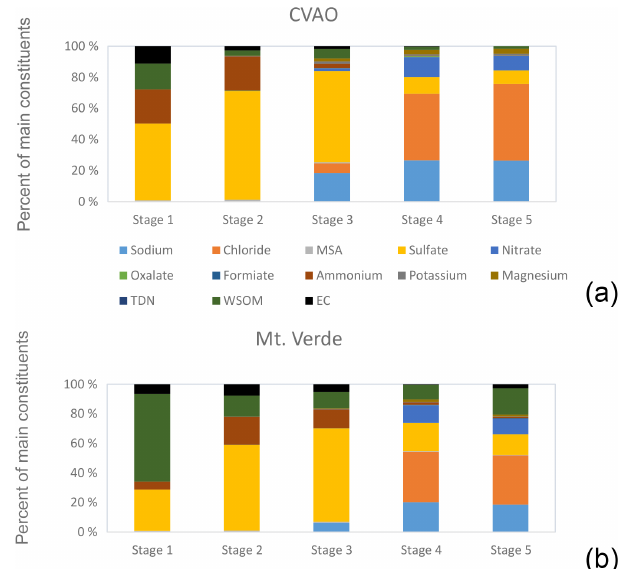
Figure 11. (a) Percentage aerosol composition at the CVAO (mean value of five blocks) and (b) at Mt. Verde (mean value of six blocks) between 2 and 9 October. Aerosol particles were samples in five dif- ferent size stages from 0.05 to 0.14 (stage 1), 0.14 to 0.42 (stage 2),